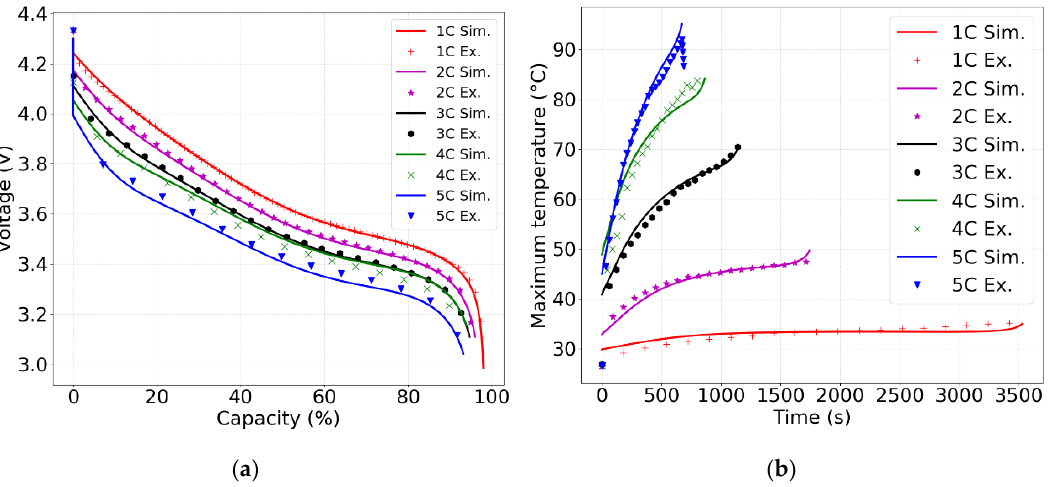
Table 2. The fitting parameters used in the Newman, Tiedemann, Gu, and Kim (NTGK) model. Parameter